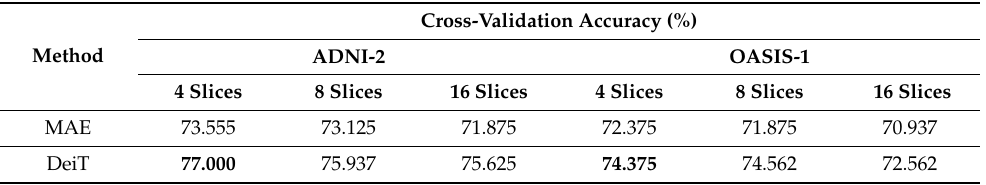
Table 3. AD/NC classification accuracy gathered by Visual Transformers. The bold style highlights the best classification results in each